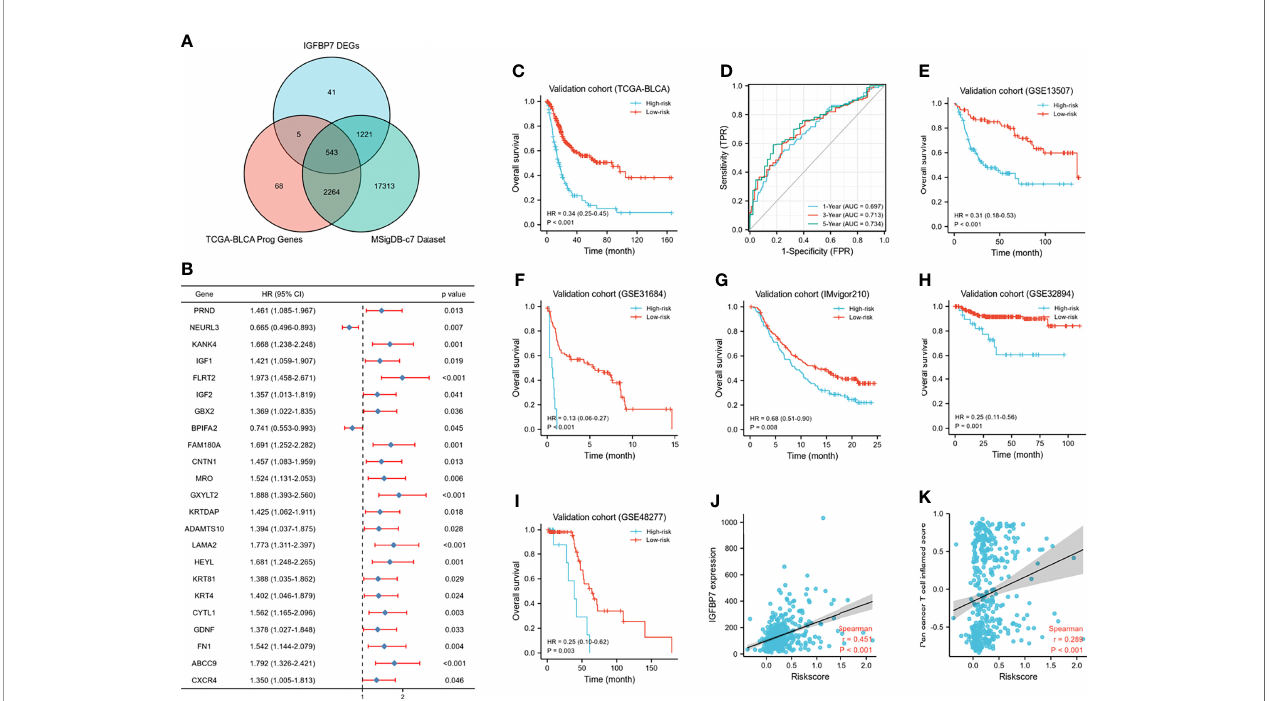
FIGURE 7 | Development of IGFBP7-based immune risk model. (A) Venn diagram showing the candidate gene set. (B) Forest plot of the correlation between the candidate genes and prognosis in BLCA. (C, D) Kaplan-Meier survival curve analysis of the low- and high-risk in TCGA training set and the predictive accuracy of risk model for survival. (E – I) Validation of the risk model in fi ve external independent sets: GSE13507, GSE31684, GSE32894, GSE48277, IMvigor210. (J, K) Correlations between riskscore, expression of IGFBP7 and pan-cancer T cell in fl amed